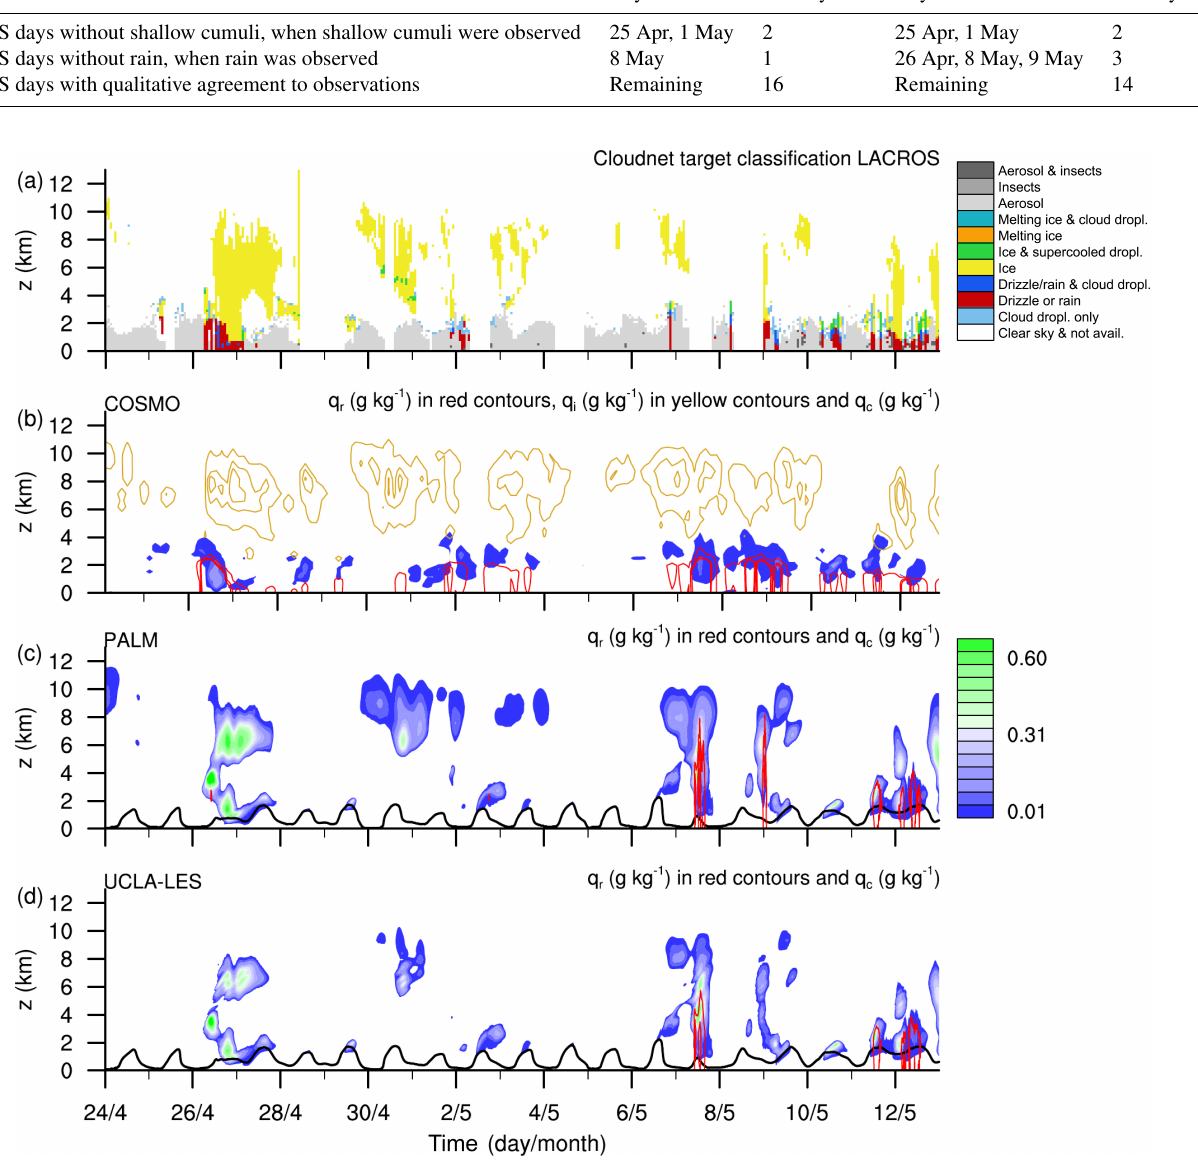
Figure 4. Time–height cross sections of Cloudnet target classification in (a) , specific cloud ice q i (in yellow contours ranging from 0.001 to 0.21gkg − 1 by 0.1gkg − 1 ), specific rainwater q r (in red contours ranging from 0.001 to 0.01gkg − 1 by 0.05gkg − 1 ) and specific cloud water q c (colored contours) of the COSMO forcing in (b) , specific cloud and rainwater of PALM (run RP) in (c) , and specific cloud and rainwater of UCLA-LES (run RU) in (d) . The red contours in (c) and (d) have the same values as in (b) . The black lines in (c) and (d) denote the boundary layer depth according to the bulk Richardson number criterion (see also Fig. 5). The same color bar is used in (b) – (d) . Note that in (b) – (d) the time series of horizontally averaged profiles are